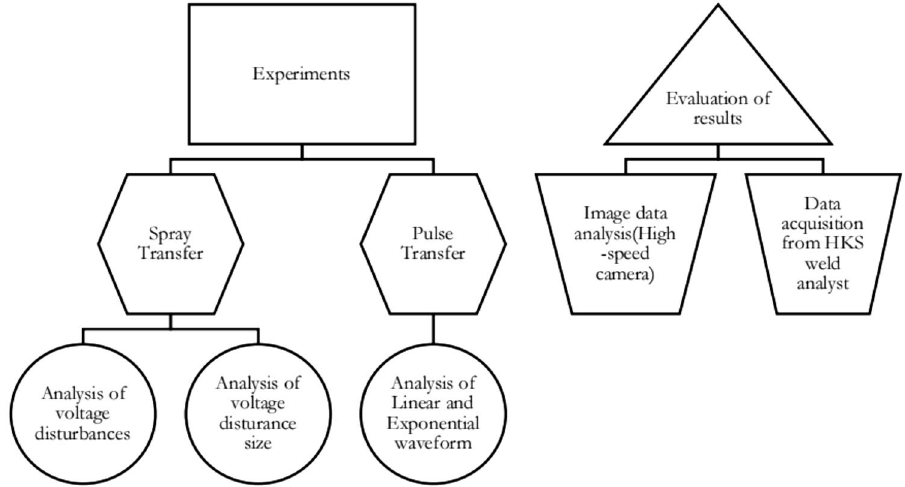
Fig. 1 Flow chart showing an experimental